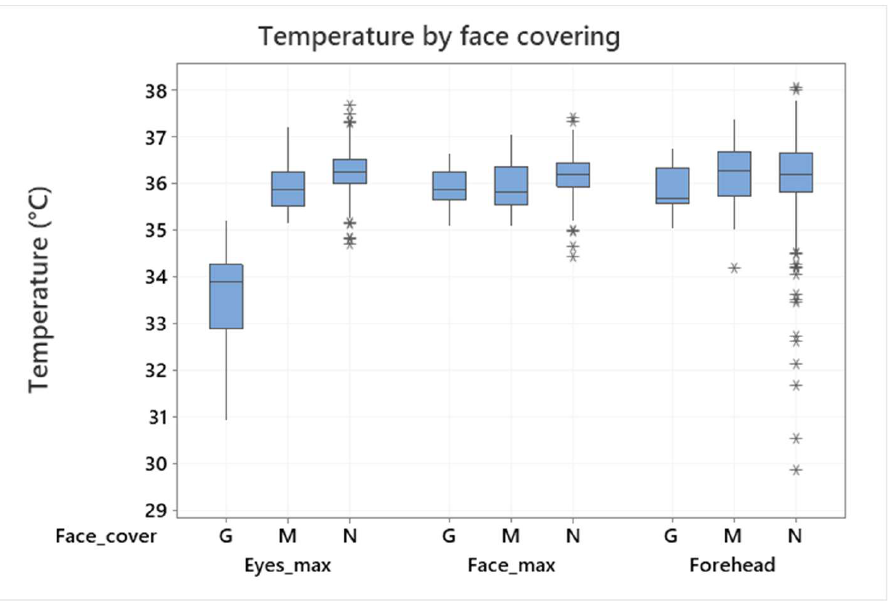
Figure 8. Maximum eyes/face temperature and forehead temperature in relation to face covering: G–glasses, M–facemask, N–none (armpit normalization applied). Outliers are identified by asterisks (*).